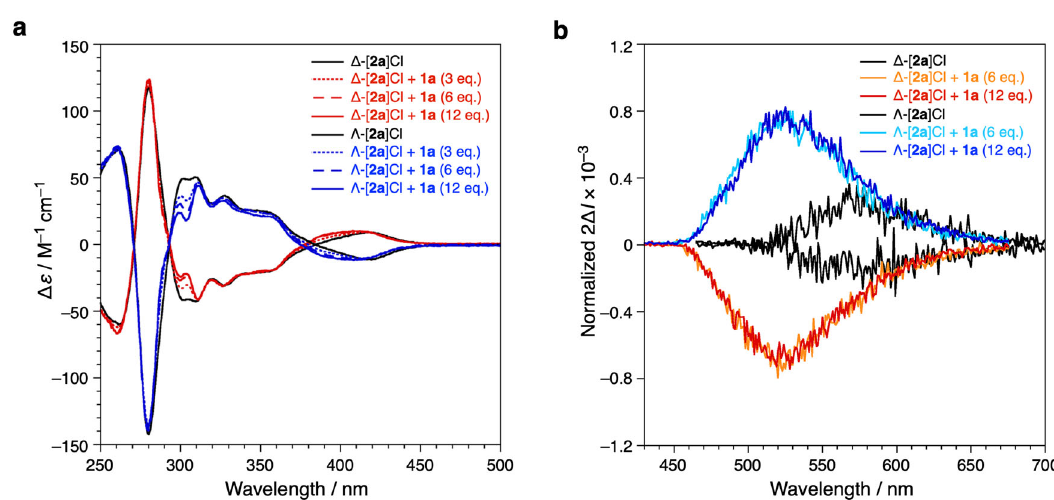
Fig. 5 | Chiroptical properties of the complexes. a Circular dichroism (CD) spectra(10 μ M,CHCl 3 ,RT)of Δ -and Λ -[ 2a ]Clinthepresenceofresorcin[4]arene 1a (0, 30, 60, 120 μ M). b Normalized circularly polarized luminescence (CPL) spectra (50 μ M, CHCl 3 , RT) of enantiomerically pure Ir complex [ 2a ]Cl (50 μ M) with